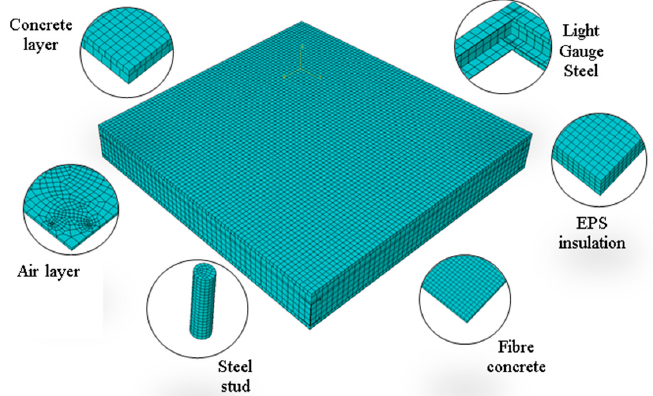
Figure 5. Mesh of the LAEWP and each component.